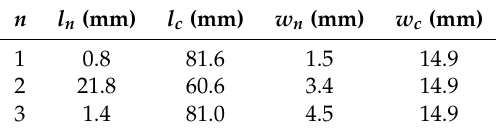
Table A2. Geometrical parameters for the resonators used in sample N =